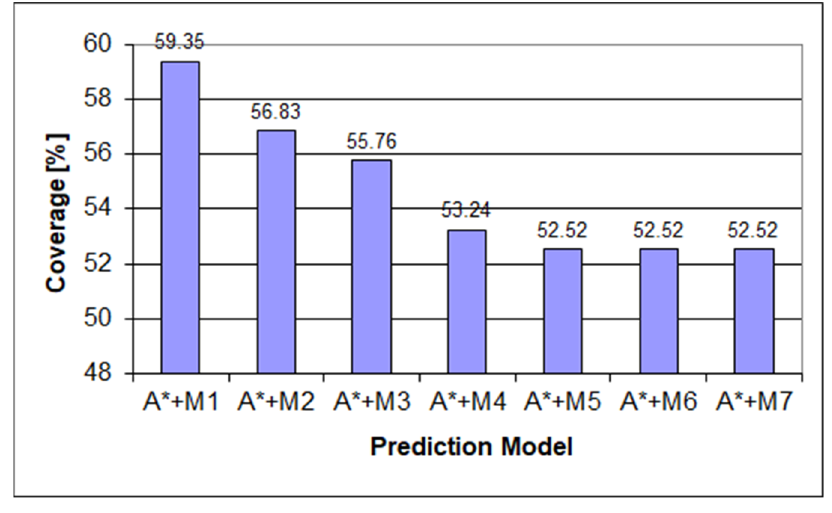
Figure 6. Predictor coverage graph for underestimating heuristic on the mixed dataset.